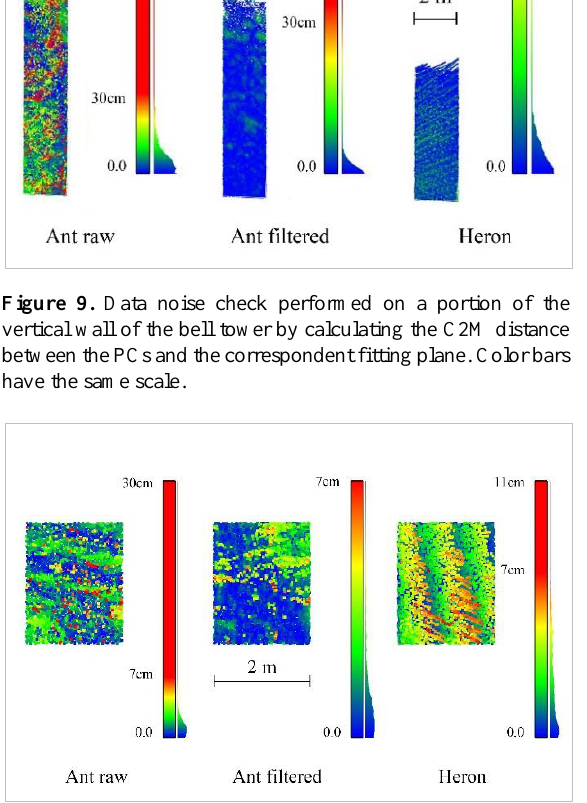
Figure 10. Data noise check performed on a portion of the paving of Prosto’s square by calculating the C2M distance between the PCs and the correspondent fitting plane. Color bars have the same scale.